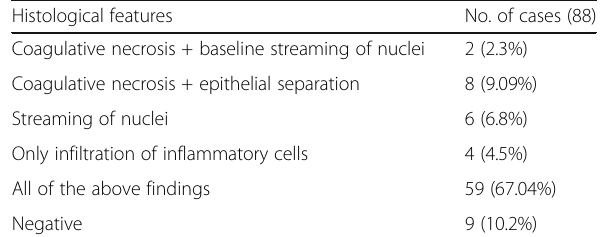
Table 7 Distribution of cases according to type of electric injury